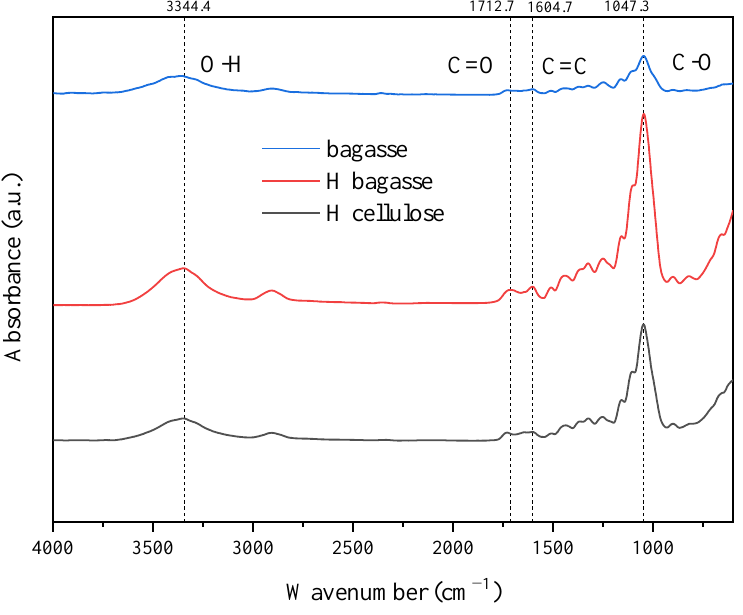
Figure 4. Infrared spectra of bagasse, HB and HC.